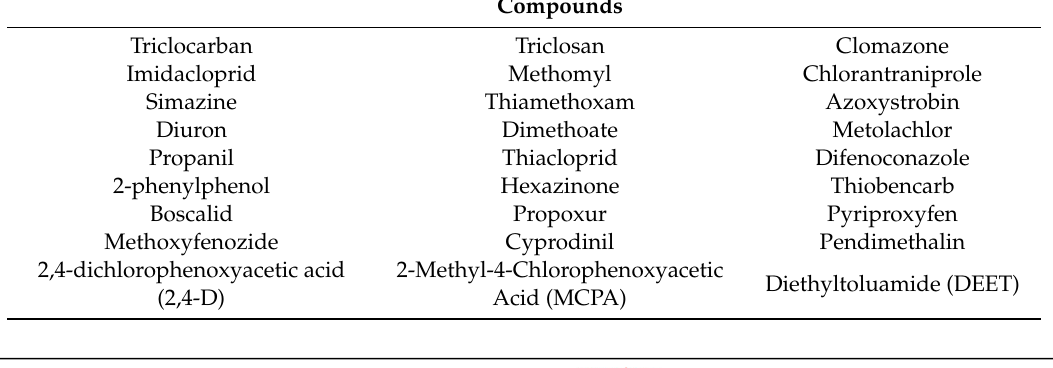
Figure 2. Suspect screening results for GC-Q/TOF-MS data.